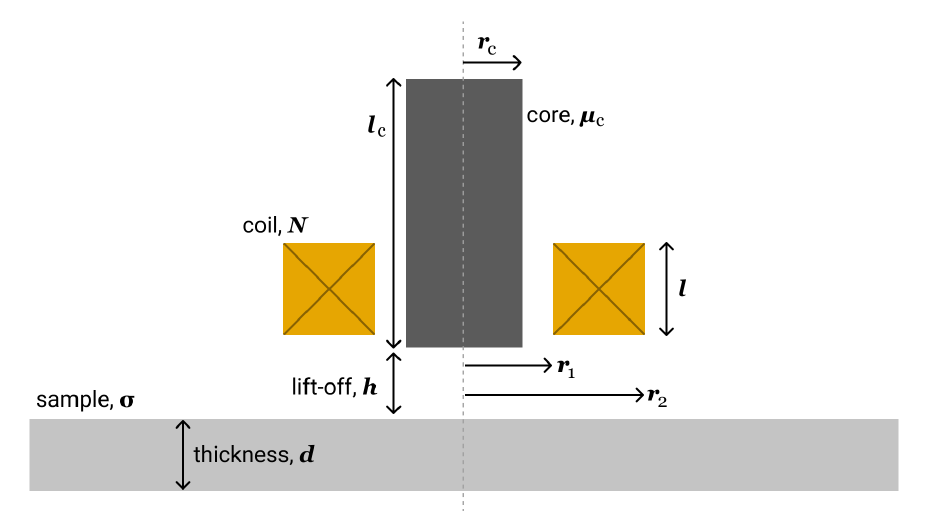
Figure 1. Sheme of eddy current (EC)-sensor and experimental